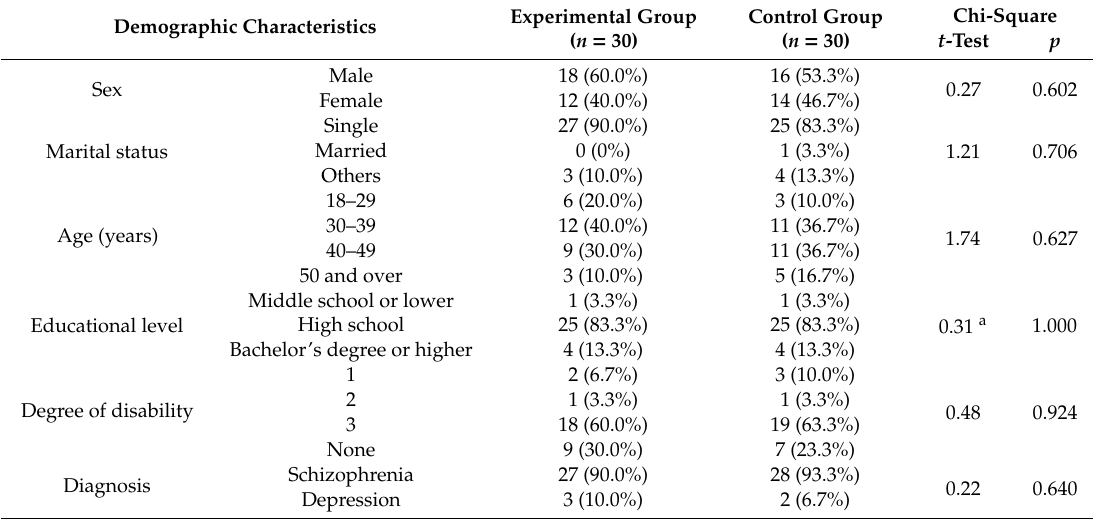
Table 2. Homogeneity of demographic